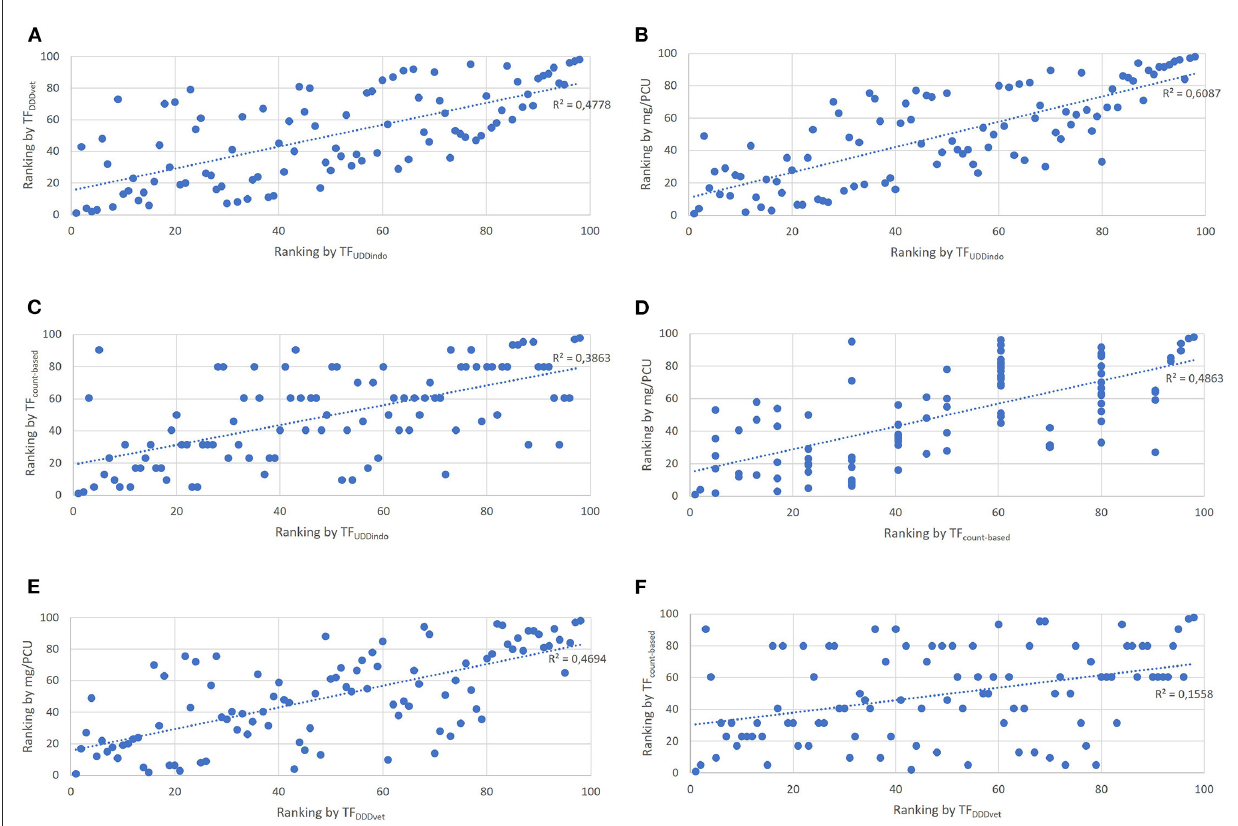
FIGURE4 Scatter plots showing the correlation of individual production cycle AMU rankings between the 4 tested AMU indicators. (A) Correlation between TF DDDvet and TF UDDindo . (B) Correlation between mg/PCU and TF UDDindo . (C) Correlation between TF count − based and TF UDDindo . (D) Correlation between mg/PCU and TF count − based . (E) Correlation between mg/PCU and TF DDDvet . (F) Correlation between TF count − based and TF DDDvet